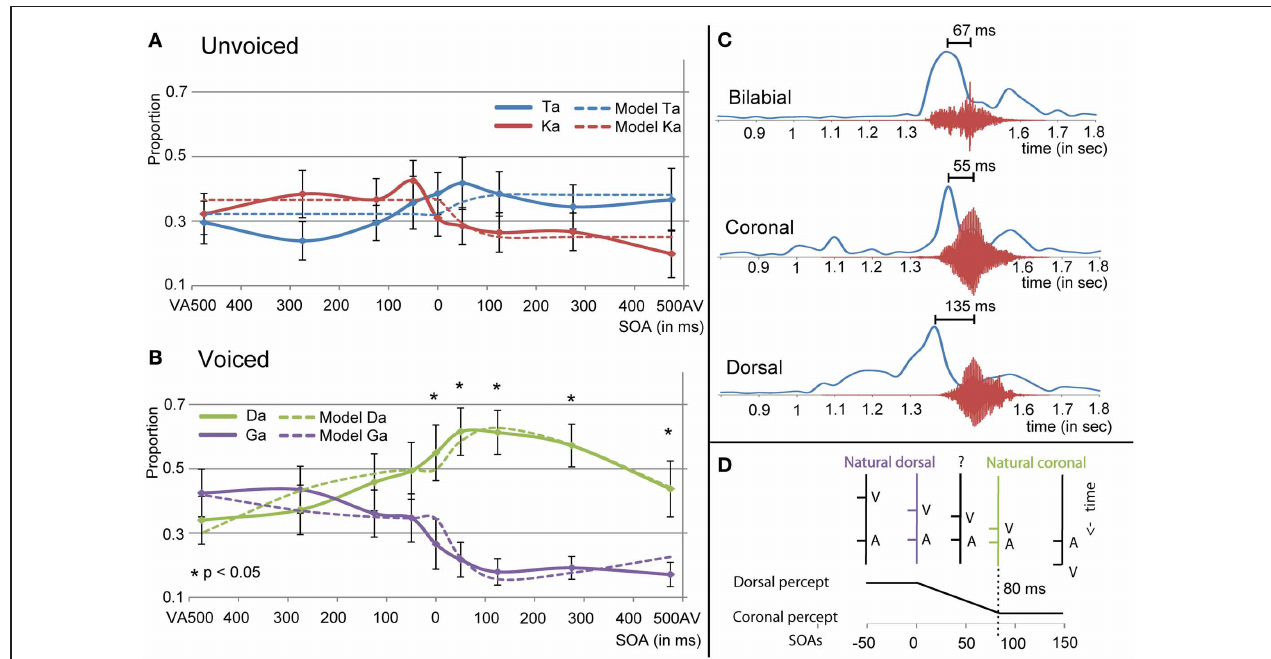
analyses using the natural dorsal and coronal onset asynchronies. The fit of the model together with the other significant predictors in the mixed model analyses is represented in (A,B) as dashed